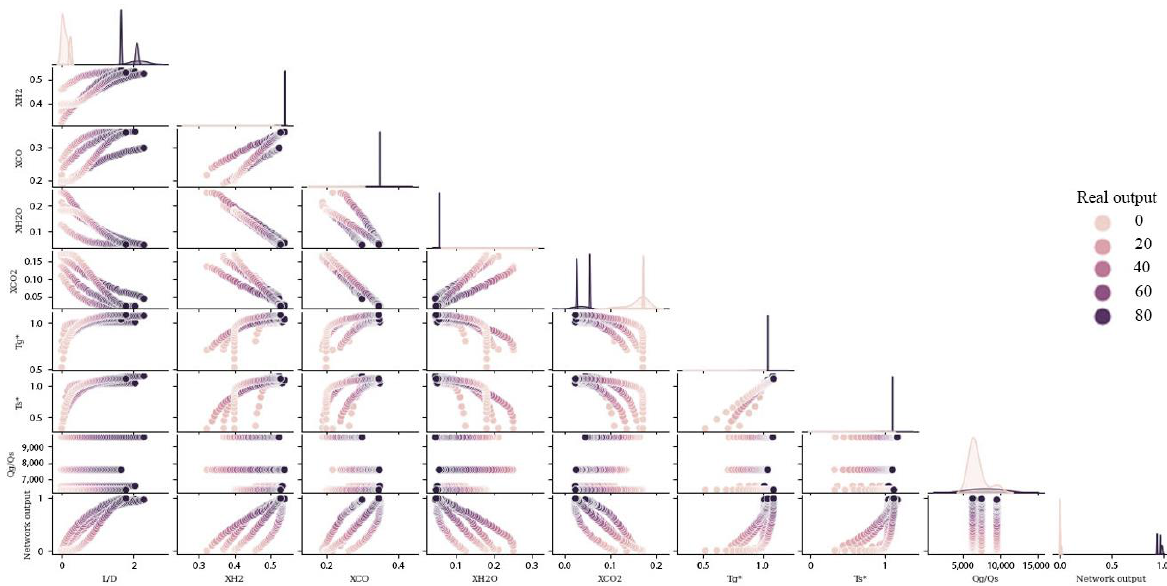
Figure 15. Comparing the effects of different parameters on each other and on the amount of solid conversion (based on dimensionless